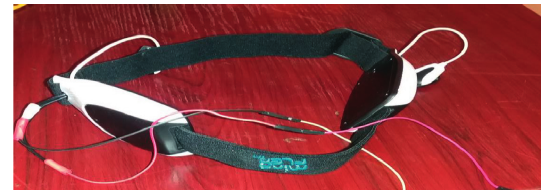
Figure 4: NeuroSky MindFlex